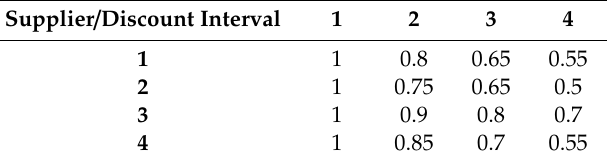
Table 6. Price discount ratios ( p ik ).